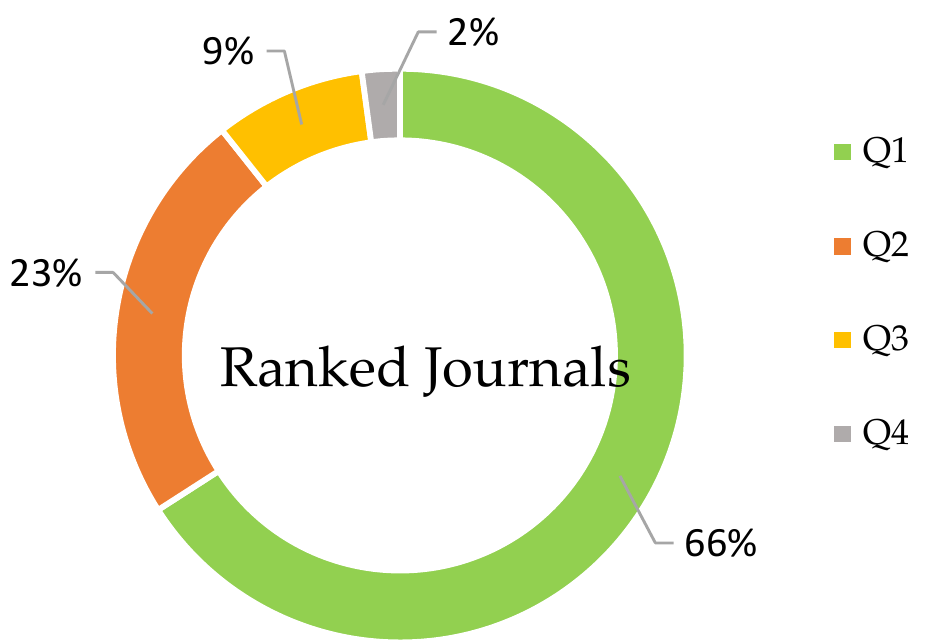
Figure 2. Percentage of ranked journals in the bibliographic data. Figure 3 depicts the historical literature review, which indicates that the largest number of publications related to this research was presented between 2019 and